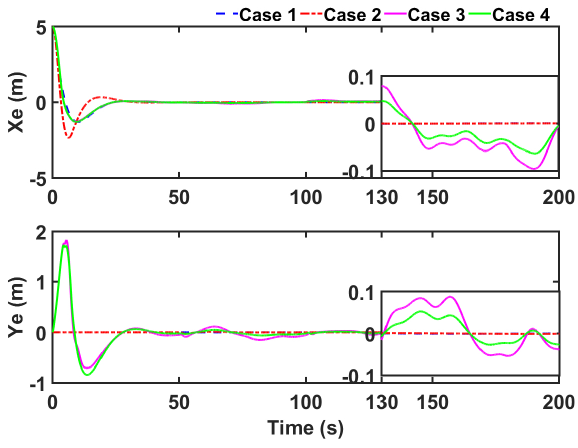
Figure 9. The trajectory tracking errors X e and Y e with four